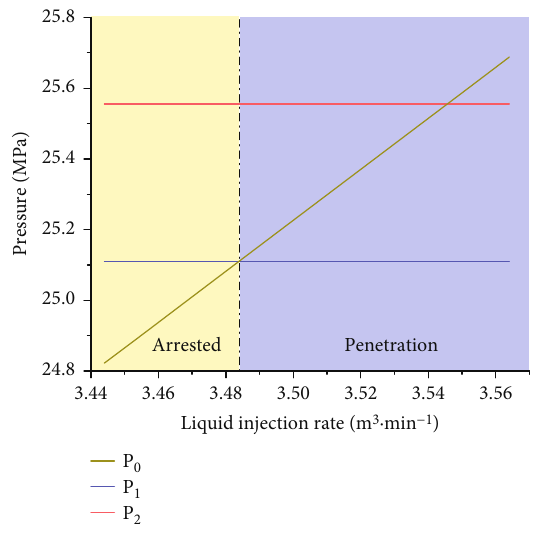
ff erent fracture